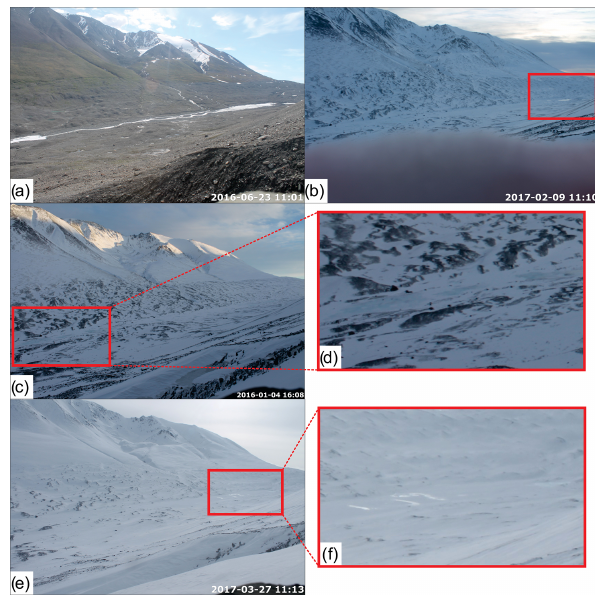
Figure 3. The Duke proglacial field visible in the TLC3 images. Panel (a) shows icings 3 (right side of the image) and 4 (left side of the image) at the camera installation; panel (b) shows an example of flooding originating from the Duke Glacier; panels (c) and (d) show an example of the darkening and/or bluing of pixels as a result of flooding; and panels (e) and (f) show an example of flooding being detectable from reflective (brightening)